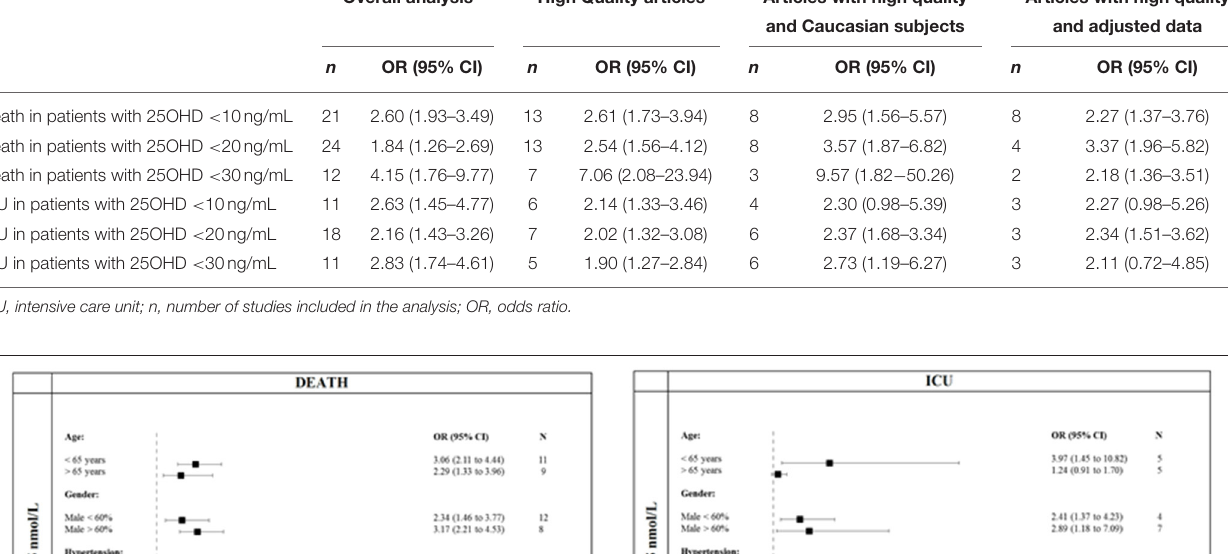
TABLE 3 | Pooled Odds Ratios of death or ICU admission due to COVID-19 in specific subgroups, in relation to 25OHD thresholds for vitamin D insufficiency, deficiency, or severe deficiency. Overall analysis High Quality articles Articles with high quality Articles with high quality